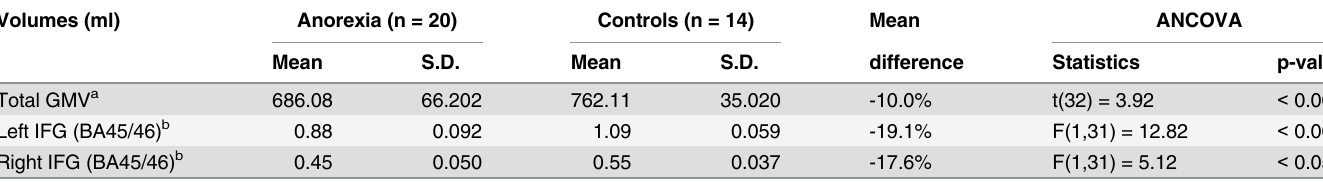
Right IFG (BA45/46)